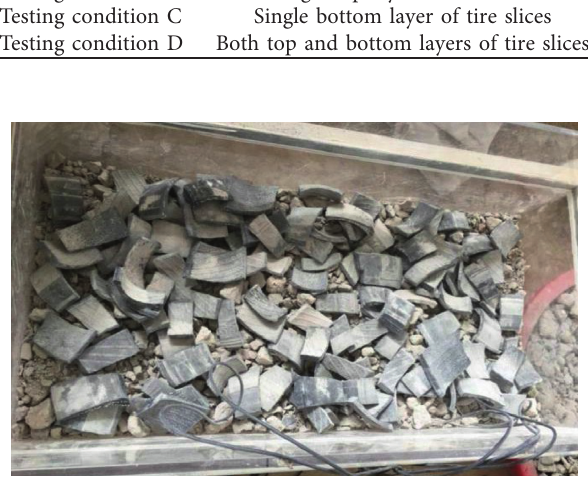
Figure 7: Laying of tire